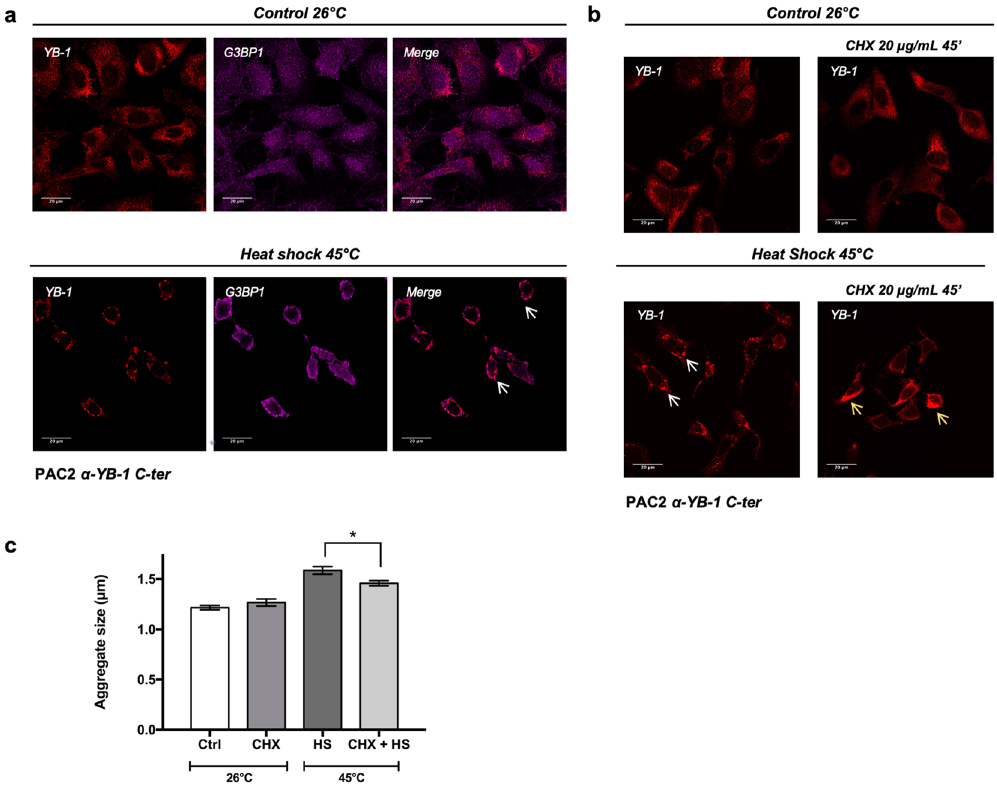
Figure 5. Heat shock induced YB-1 aggregates represent bona fide SGs. ( a ) Confocal immunofluorescence analysis of YB-1 (red) and G3BP1 (magenta) in PAC2 cells at 26 °C (control) or after heat shock at 45 °C for 45 minutes. Cellular colocalization is present in perinuclear aggregates indicated by white arrows; ( b ) confocal immunofluorescence of YB-1 in PAC2 cells treated with cycloheximide (20 µ g/ml) at 26 °C (upper part of the panel) or after heat shock at 45 °C for 45 minutes (lower part of the panel). Controls are represented in the left part of the panel. White arrows indicate YB-1 positive aggregates (lower panel, left). Yellow arrows indicate the bulk of the protein not forming aggregates (lower panel, right); ( c ) quantification of YB-1 positive SG aggregate dimensions in PAC2 cells documented in the cycloheximide treatment analysis presented in panel b. Statistical analysis was performed using 1-way ANOVA followed by Tukey’s multiple comparisons test. Levels of significance are indicated ( * p = 0.05) (see also Table